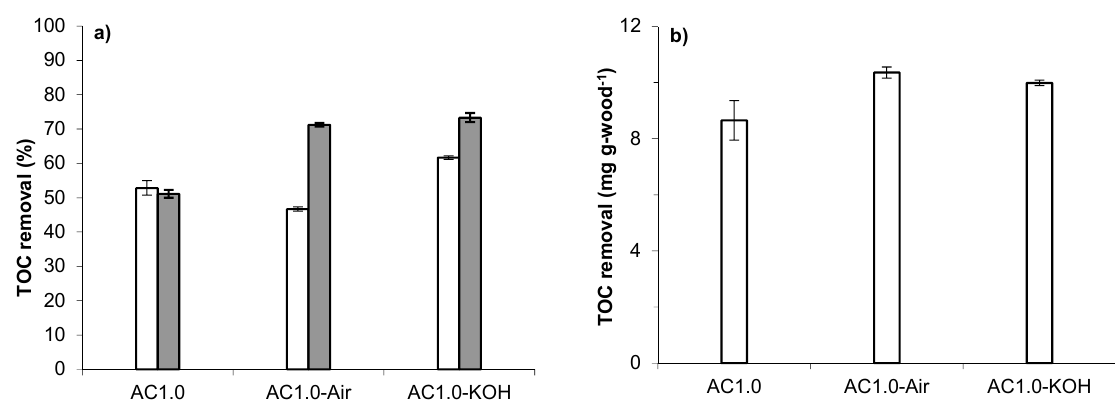
Figure 5. TOC removal by activated carbon prepared from the mixture of wood and bio-oil (white and grey bars for as prepared and HT carbon, respectively): ( a ) in per cent of removed organic carbon from water; and ( b ) in mg of organic carbon per mass of wood used for carbon production.